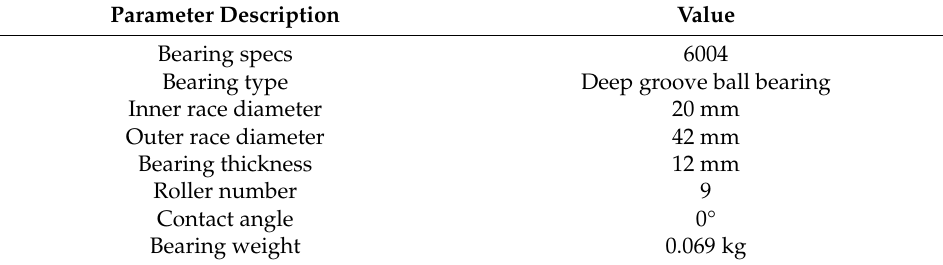
Figure 11. Examples of experimental signals. ( a ) Normal; ( b ) inner race fault; ( c ) outer race fault; ( d ) cage fault. Table 6. Bearing